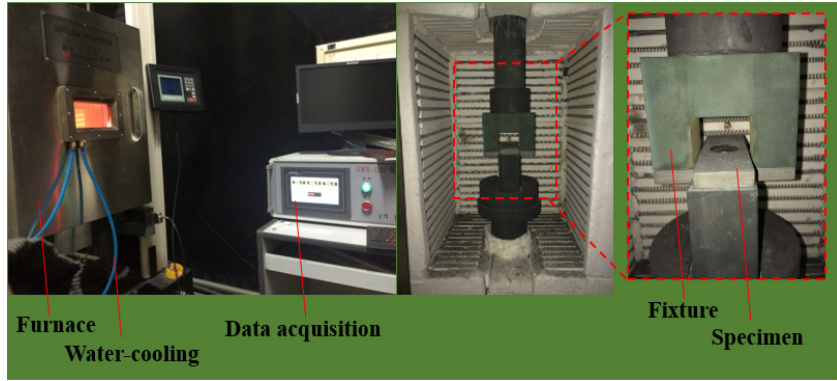
Figure 7. Test equipment and specimen fixture.